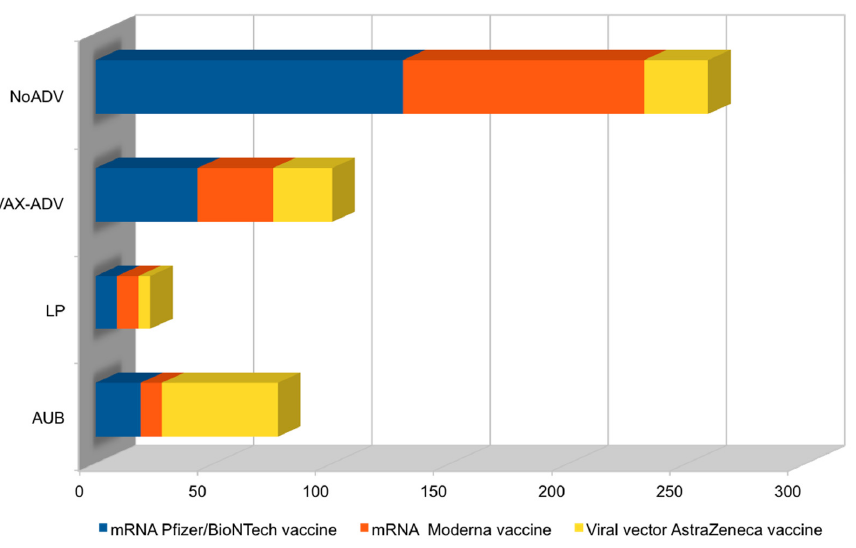
Figure 1. Histogram of COVID-19 vaccine types and corresponding adverse effects. Legend and abbreviations: y = vaccinated women with menstrual irregularities due to other causes, NoADV/vaccinated women whose menstrual irregularities could be adverse effects to vaccine, VAX-ADV/which adverse effect, late period, LP, or abnormal uterine bleeding, AUB; x = number of all vaccinated women with menstrual irregularities.